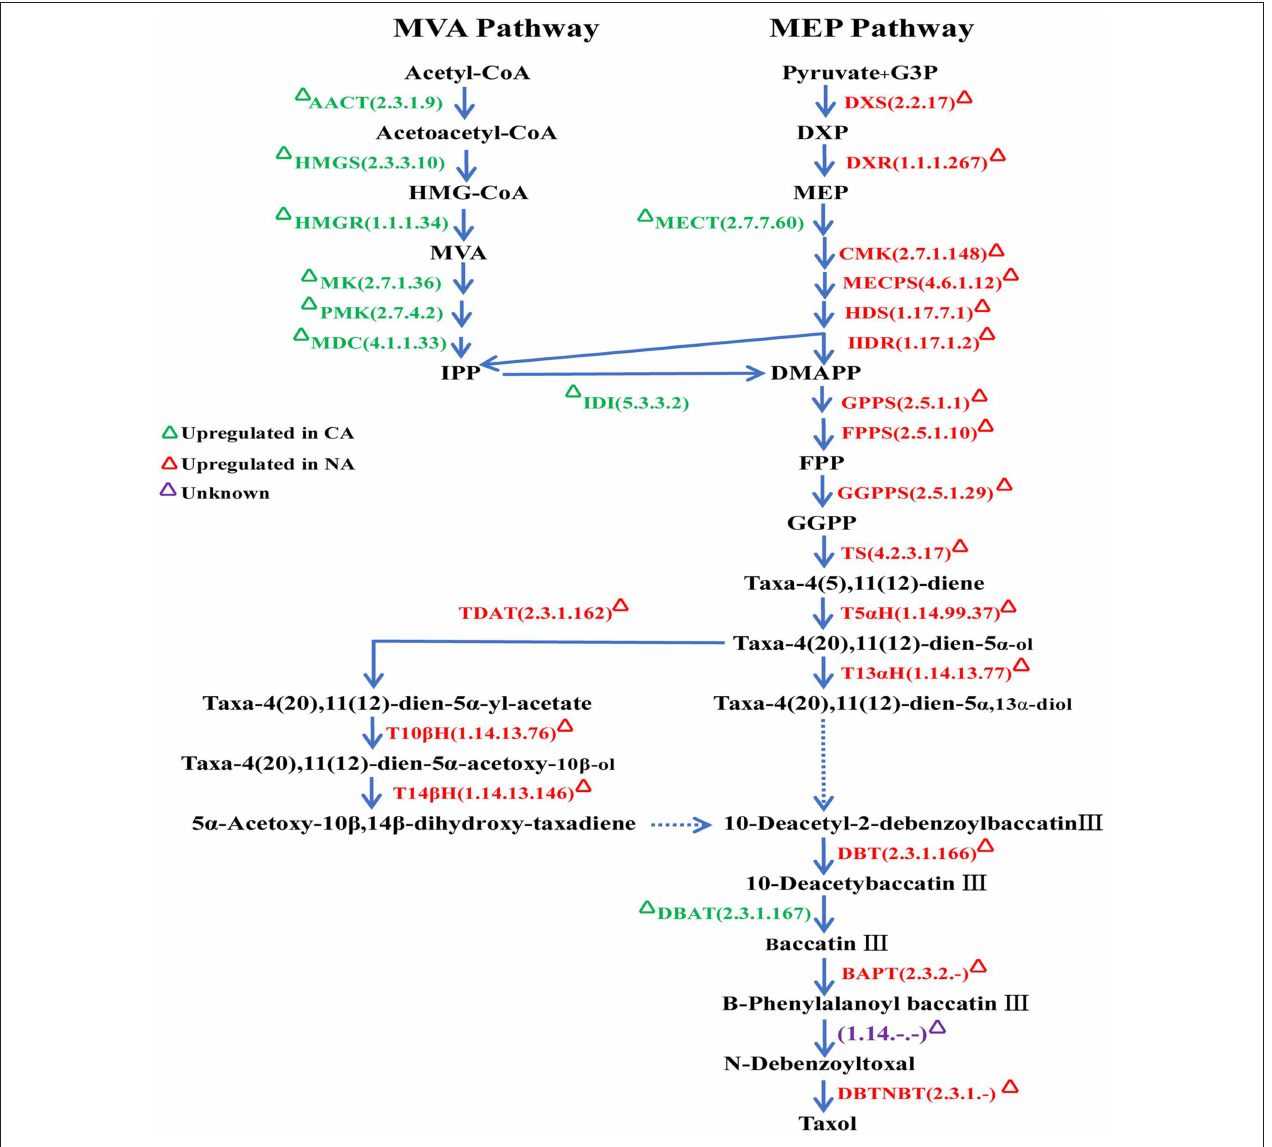
FIGURE 4 | Schematic representation of the taxol biosynthetic pathway. Enzymes were marked according to their specific expression in CA and NA. AACT, acetyl-CoA C-acetyltransferase; HMGS, hydroxymethylglutaryl-CoA synthase; HMGR, hydroxymethylglutaryl-CoA reductase; MK, mevalonate kinase; PMK, phosphomevalonate kinase; MDC, diphosphomevalonate decarboxylase; DXS, 1-deoxy-D-xylulose-5-phosphate synthase; DXR, 1-deoxy-D-xylulose-5-phosphate reductoisomerase; MECT, 2-C-methyl-D-erythritol 4-phosphate cytidylyltransferase; CMK, 4-diphosphocytidyl-2-C-methyl-D-erythritol kinase; MECPS, 2-C-methyl-D-erythritol 2,4-cyclodiphosphate synthase; HDS, (E)-4-hydroxy-3-methylbut-2-enyl-diphosphate synthase; HDR, 4-hydroxy-3-methylbut-2-en-1-yl diphosphate reductase; IDI, isopentenyl-diphosphate Delta-isomerase; GPPS, geranyl diphosphate synthase; FPPS, farnesyl diphosphate synthase; GGPPS, geranylgeranyl diphosphate synthase; TS, taxadiene synthase; T5 α H (CYP725A4), taxadiene 5alpha-hydroxylase; T13 α H (CYP725A2), taxane 13-alpha-hydroxylase; TDAT, taxadien-5-alpha-ol O-acetyltransferas; T10 β H (CYP725A1), taxane 10-beta-hydroxylase; T14 β H (CYP725A3), taxoid 14beta-hydroxylase; DBT, 2-alpha-hydroxytaxane 2-O-benzoyltransferase; DBAT, 10-deacetylbaccatinIII 10-O-acetyltransferase; BAPT, Baccatin III amino phenylpropanoyl-13-O-transferase; DBTNBT, 3 ′ - N -debenzoyl-2 ′ -deoxytaxol N -benzoyl